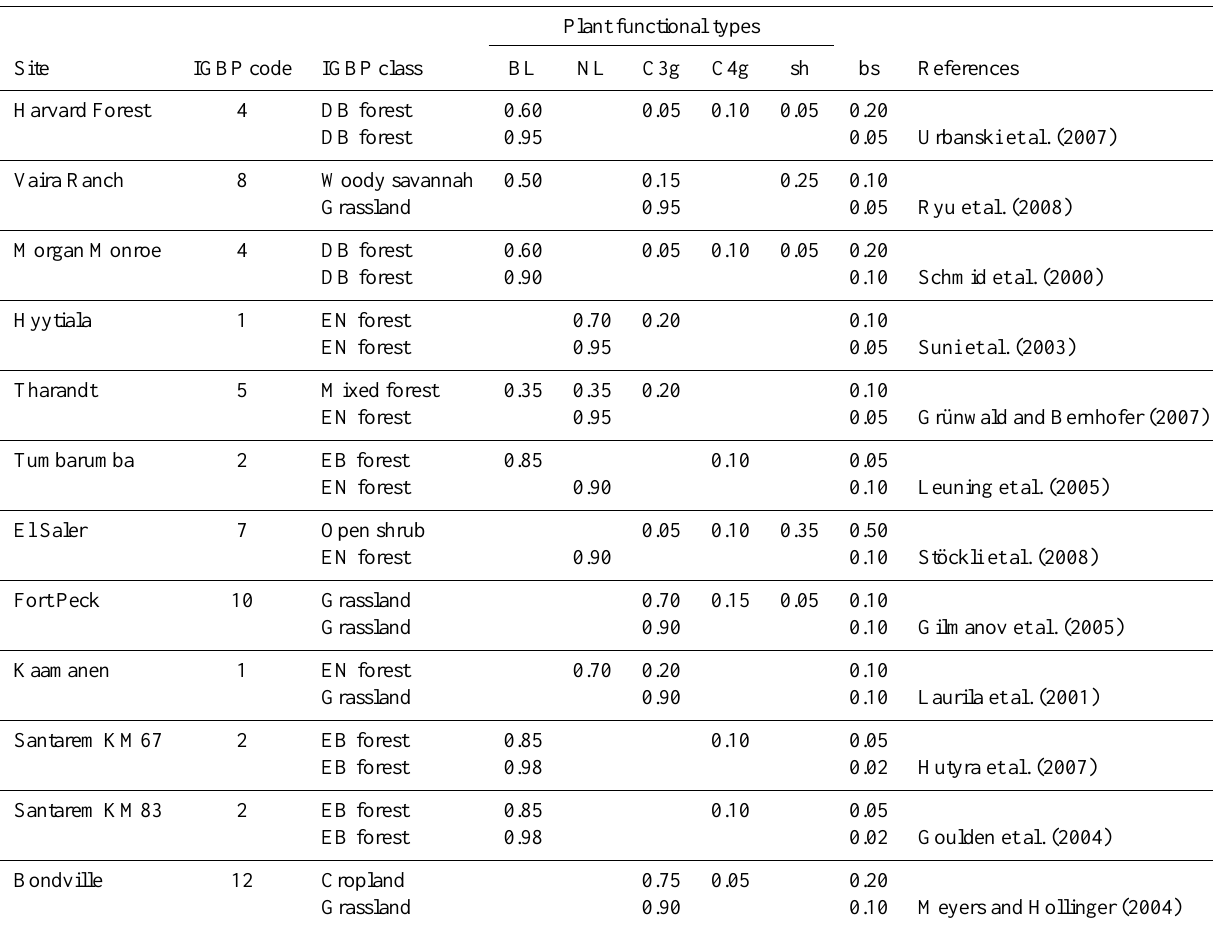
Table 5. Vegetation (PFT) and non-vegetation land cover type (BL: broadleaf tree, NL: needleleaf tree, C3g: C3 grass, C4g: C4 grass, sh: shrubs, bs: bare soil) fractions at the 12 FLUXNET sites. For each site, the first row refers to global data and the second refers to